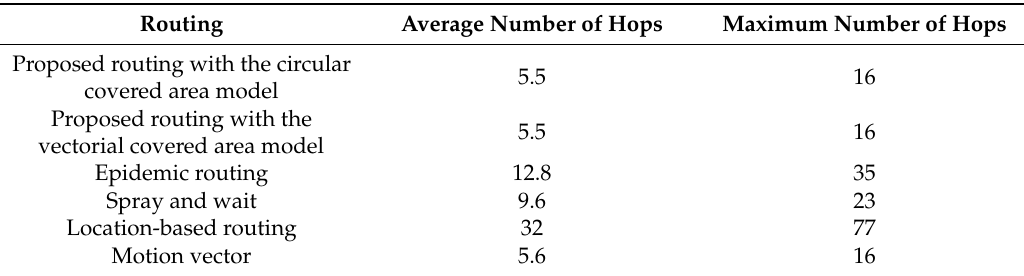
Table 4. Comparison in terms of the number of hops.